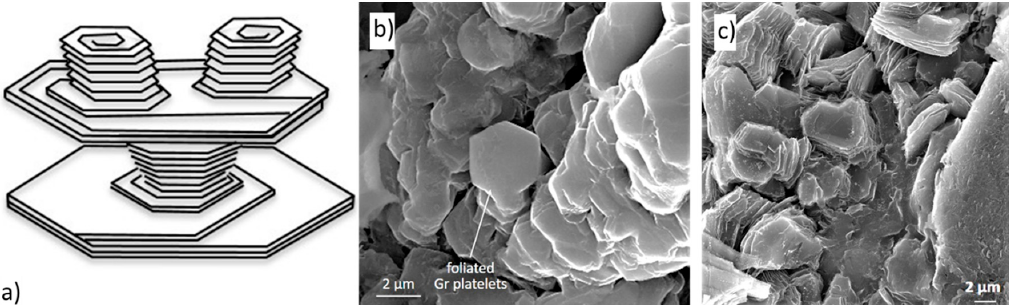
Figure 11. Foliated crystals growing in columnar mode: ( a ) Schematic representation, reproduced from [30] with permission from Elsevier; ( b ) stacking of foliated hexagonal platelets in the c -direction in CG iron, reproduced from [42] with permission from Springer; ( c ) growth of blocky graphite from foliated platelets in 0.01%Sb CG iron, reproduced from [42] with permission from Springer. Disclinations are line defects corresponding to “adding” or “subtracting” an angle around a line. The positive wedge disclination mechanism was suggested by Amelinckx et al. [45] who argued that the initial graphite layer adopts a slitted dome-shaped configuration by introducing a fivefold carbon ring in the six-fold carbon network. Successive sheets are rotated with respect to the previous one